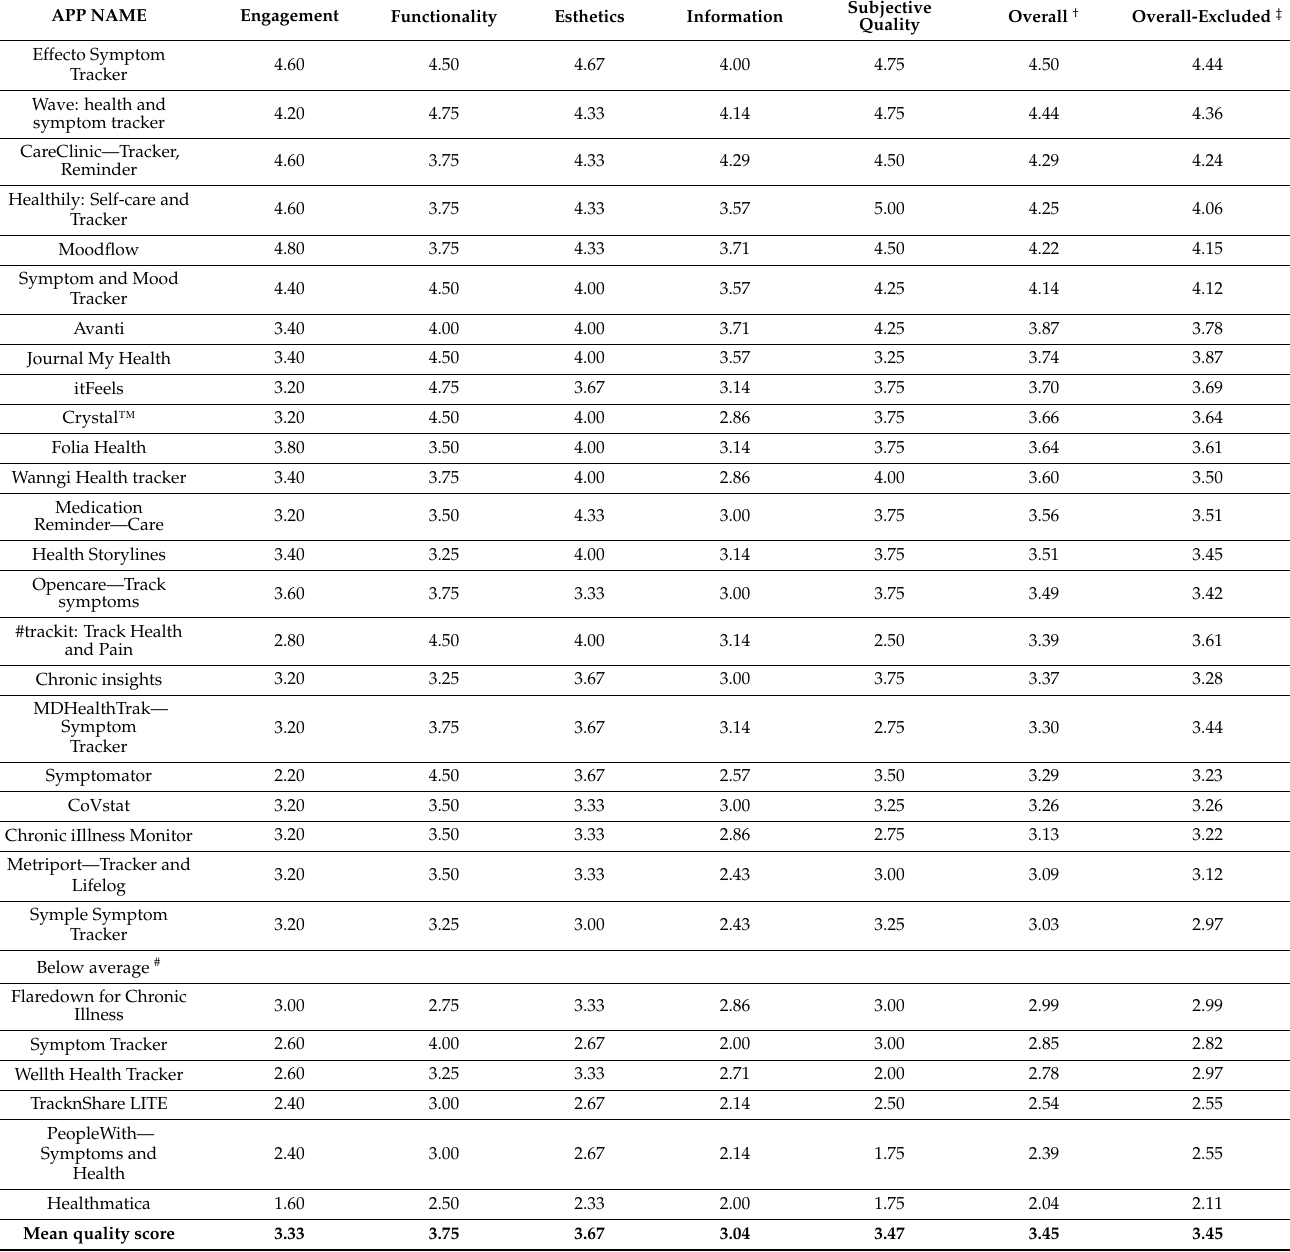
Table 3. Mobile App Rating Scale (MARS) mean scores of the included mHealth apps. Rating out of